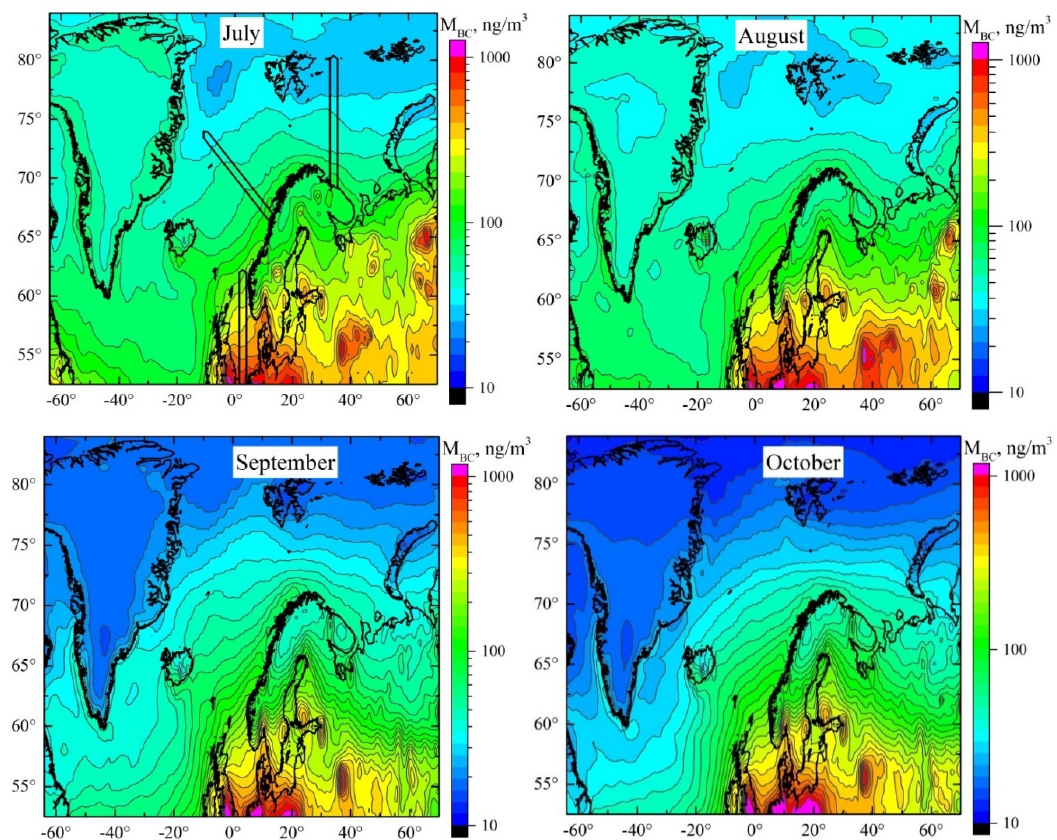
Figure 8. Average monthly (July, August, September, October) spatial distributions of M BC according to MERRA-2 reanalysis; black arrows indicate the directions of decreasing concentrations in the sectors of the North, Norwegian and Barents Seas, which are analyzed in Figure 9.